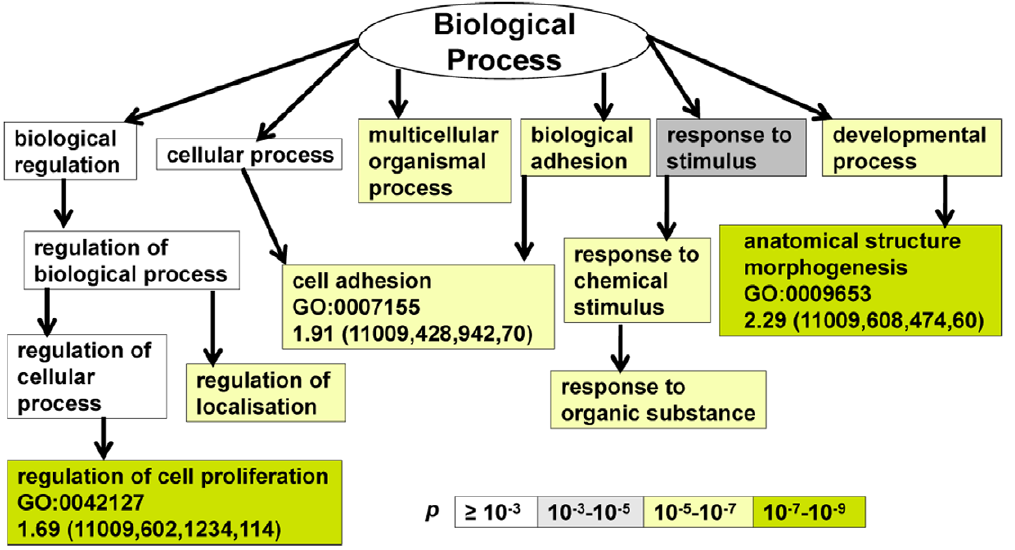
Figure 6. Biological processes affected by ER silencing. GO terms most significantly affected or disrupted secondary to ER silencing. Each GO term is boxed in a rectangle and shaded according to the p value as indicated. Enrichment (N, B, n, b), where indicated is defined as (b/n)/(B/N), where N - is the total number of genes, B - is total number of genes associated with a specific GO term (‘target’ set and ‘background set’), n - is number of genes in the ‘target set’, b - is number of genes in the ‘target set’ associated with a specific GO term.